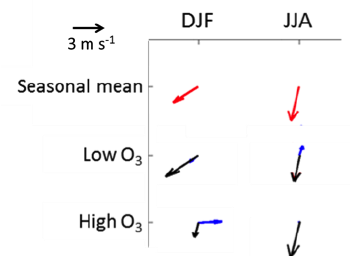
Figure 10. Mean 10m winds at Tacubaya station (TCBY in Fig. 1) at 18:00UTC (12:00LT). Mean surface wind vectors for each sea- son, DJF and JJA, are on row one and indicated by red arrows. Mean (black arrows) and anomaly (blue arrows) vectors for the MJO phases associated with lowest surface ozone (phase 8 in DJF and phase 1 in JJA) are on the middle row. Mean (black arrows) and anomaly (blue arrows) vectors for the MJO phases associated with highest surface ozone (phase 2 in DJF and phase 6 in JJA) are on the bottom row. Note that the mean winds for low ozone in DJF and high ozone in JJA are very similar to the seasonal mean winds, so the anomaly (blue) vector is very small. All wind data are from NOAA National Centers from Environmental Information, 1986–